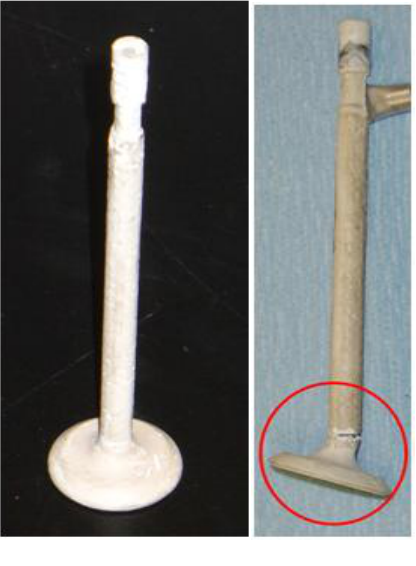
Figure 1. Resin Transfer Molded, Nextel 440/MEYEB composite Engine Valve and brittle handling